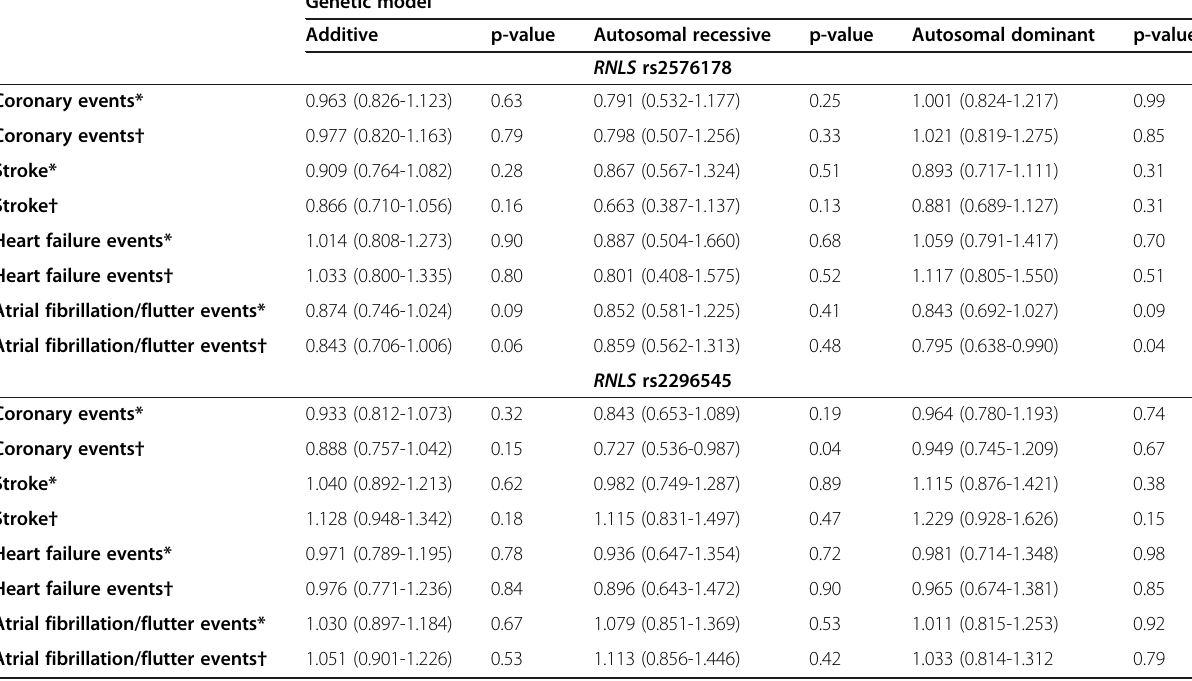
Table 4 Hazard ratio and 95% CI for different cardiovascular events conferred by the RNLS rs2576178 A > G and rs2296545 C > G polymorphisms tested by COX regression according to different genetic model in